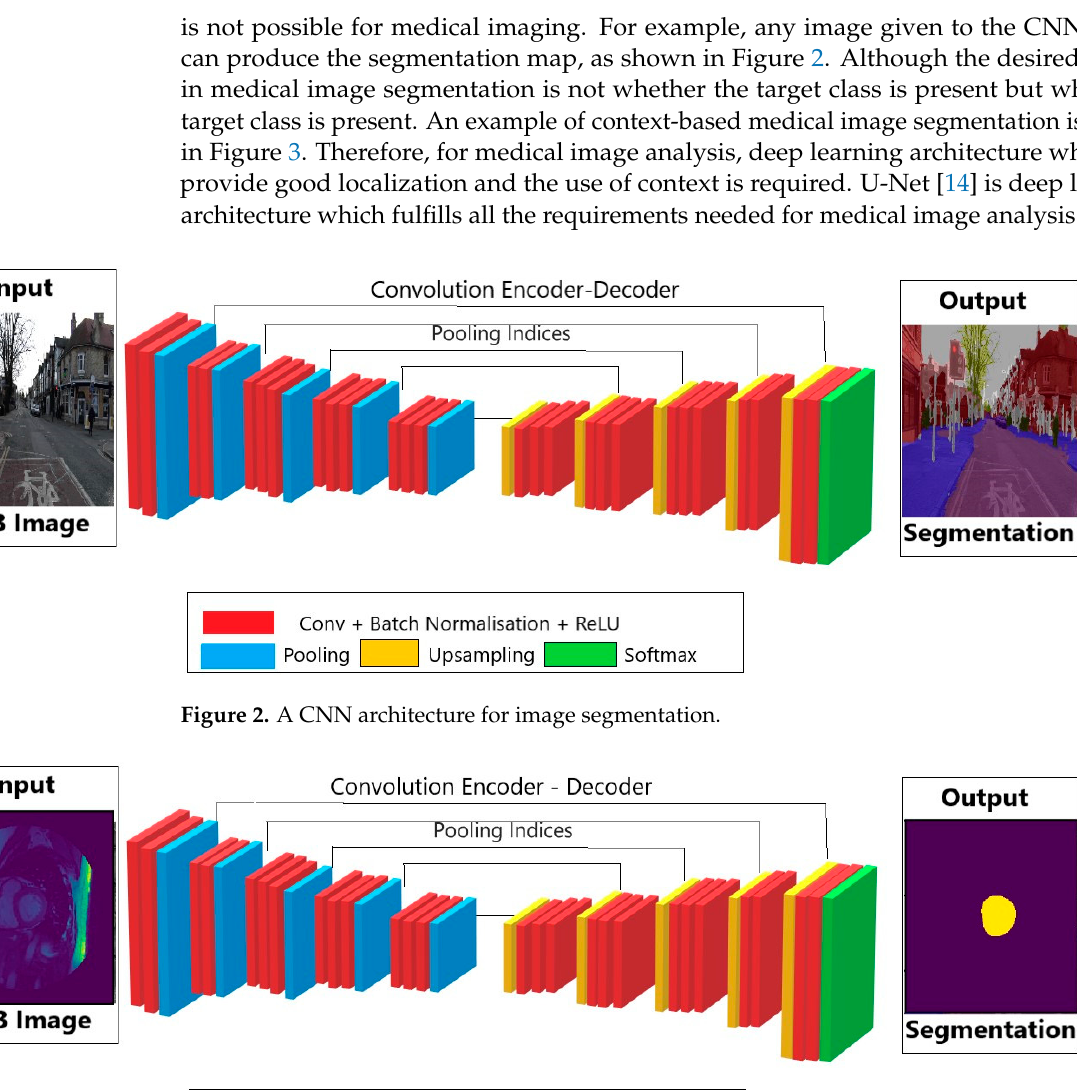
Figure 3. An example of context enabled segmentation.